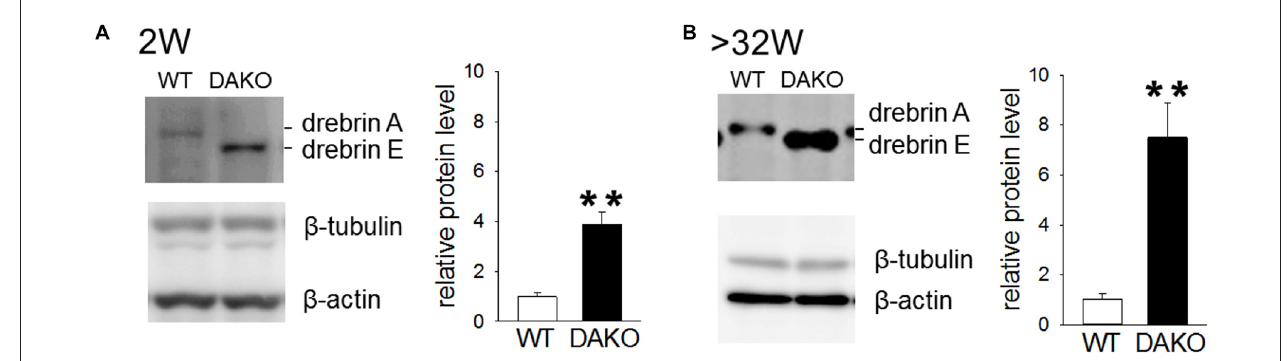
FIGURE 5 | Drebrin E accumulates in synaptosome from DAKO mice. (A) Quantitative analyses of drebrin content in synaptosome from the cerebral cortices of developing WT ( n = 3) and DAKO mice ( n = 3). Equal amounts of protein (25 µ g/lane) were subjected to SDS-PAGE/Western blot analysis. Blots were probed with antibodies against drebrin, β -tubulin and β -actin, and positive bands were visualized with enhanced chemiluminescence (ECL) system. The intensities of ECL signals for drebrin was quantified and the drebrin levels were shown as the ratio of DAKO to WT and are presented as means ± SEM. Note that the amount of drebrin in synpatosome of DAKO mice was significantlly higher thatn that of WT mice both in developing and adult mice ( ∗∗ p < 0.01; Student’s t -test,). (B) Quantitative analyses of drebrin content in synaptosome from adult WT ( n = 4) and DAKO mice ( n = 4). For original western blot images, see Supplementary Figure S4 .